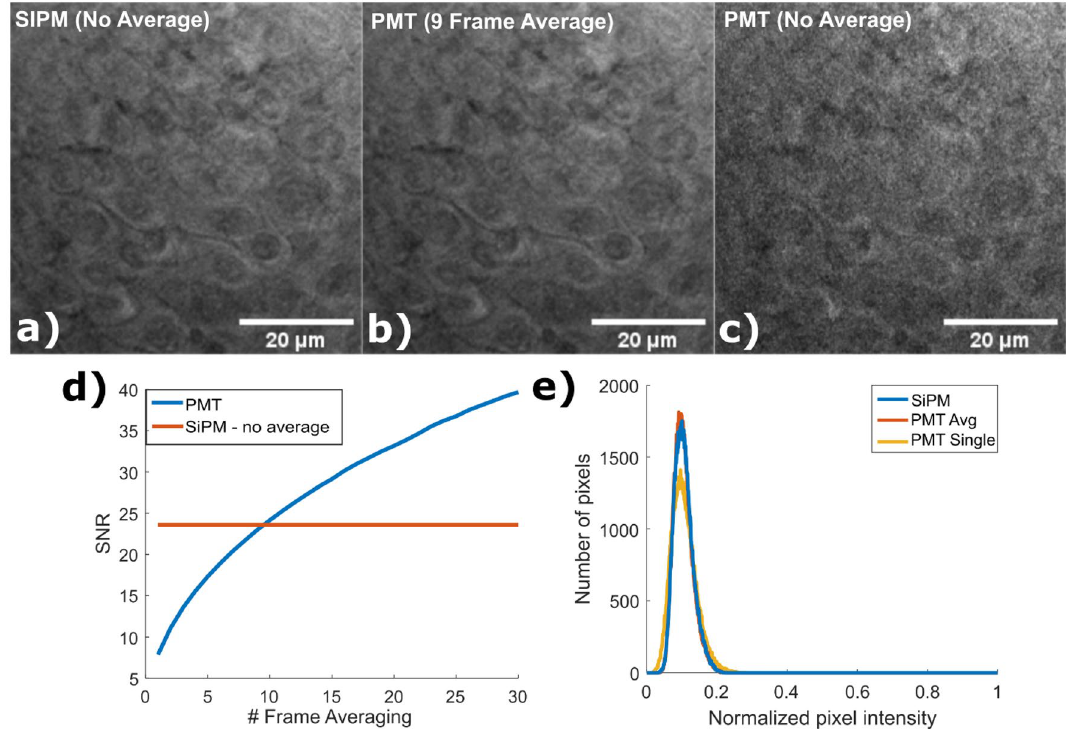
Figure 8. Comparison of SNR between the SiPM and PMT detectors. At maximum laser power, individual SiPM image frames ( a ) have similar SNR to 9.5 averaged PMT frames when operated just below the level that triggers the overcurrent protection circuit ( b ). In comparison, individual PMT frames have substantially more shot noise due to the low saturation power of the PMT ( c ). ( d ) SNR, defined as the mean pixel value divided by the standard deviation of pixel value over sequential frames, was calculated as a function of average number, giving a per frame SNR of 7.851 for the PMT and 23.574 for the SiPM. ( e ) Histogram of the pixel intensities for the image frames in (a), (b), and